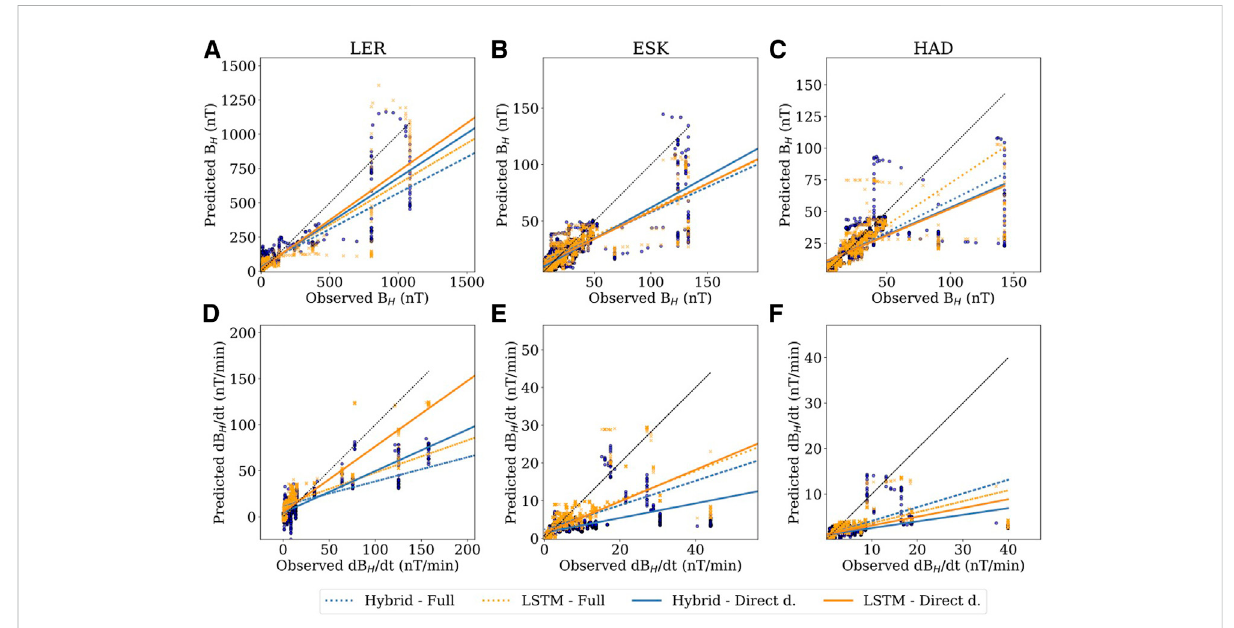
FIGURE 4 Correlation plots for forecasts of |B_H| (A – C) and |dB_H/dt| (D – F) with 30 min lead time at LER (A,D) , ESK (B,E) , and HAD (C,F) . Orange represents LSTM and blue hybrid models; solid lines are for directly driven parts of the storm and dotted lines represent full storm. Gradient and intercept for best fi t line are given in Table 3. Dotted black line shows the 1:1 line for reference.